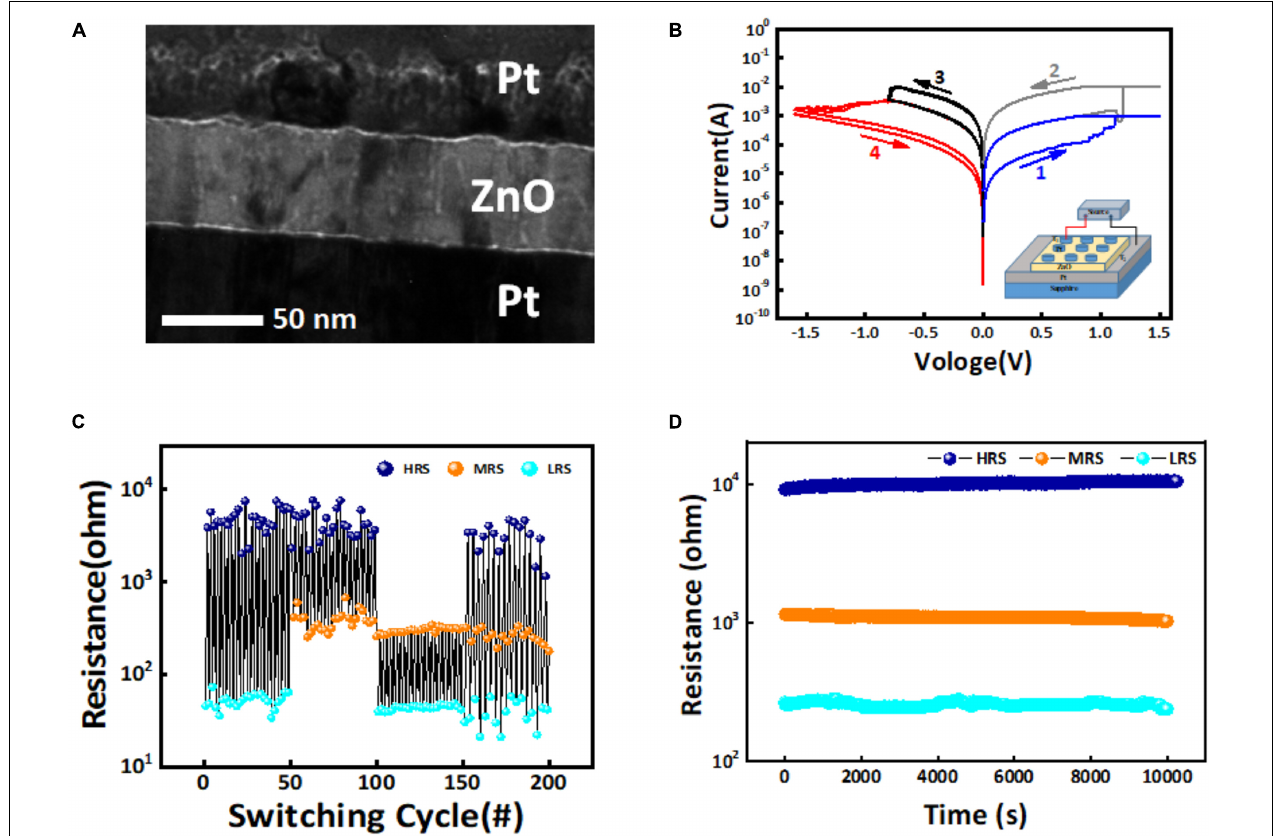
FIGURE 1 | (A) Transmission electron microscope (TEM) image of the Pt/ZnO/Pt memristor. (B) Direct current (DC) current–voltage characteristics of the Pt/ZnO/Pt memristor showing three-state switching behavior. (C,D) Show the room-temperature endurance and retention performance of the device,